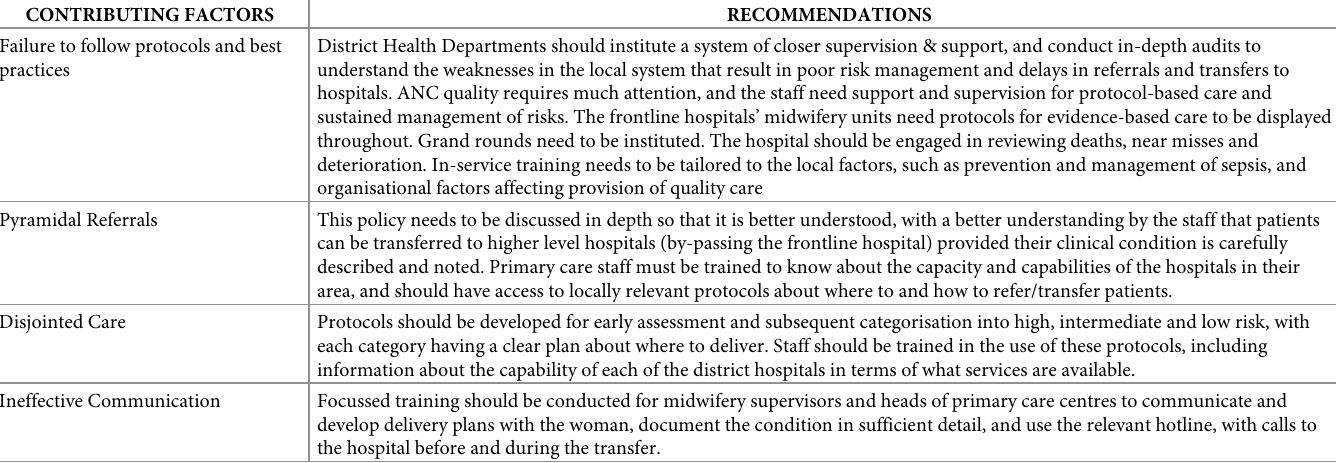
Table 3. Recommendations to address the factors contributing to maternal